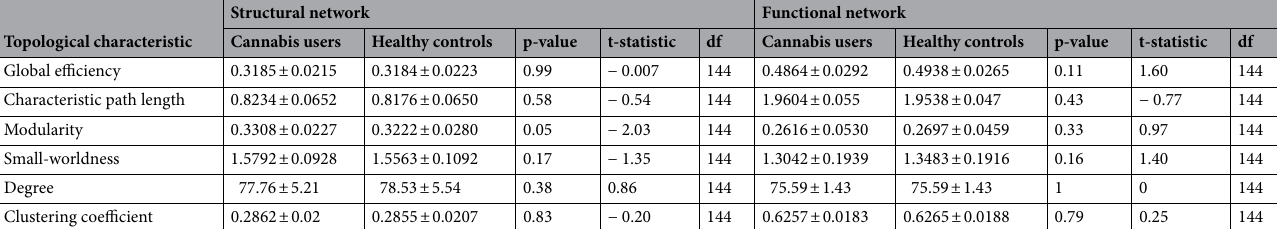
Table 2. Average values (mean ± SD) of structural and functional network properties for each